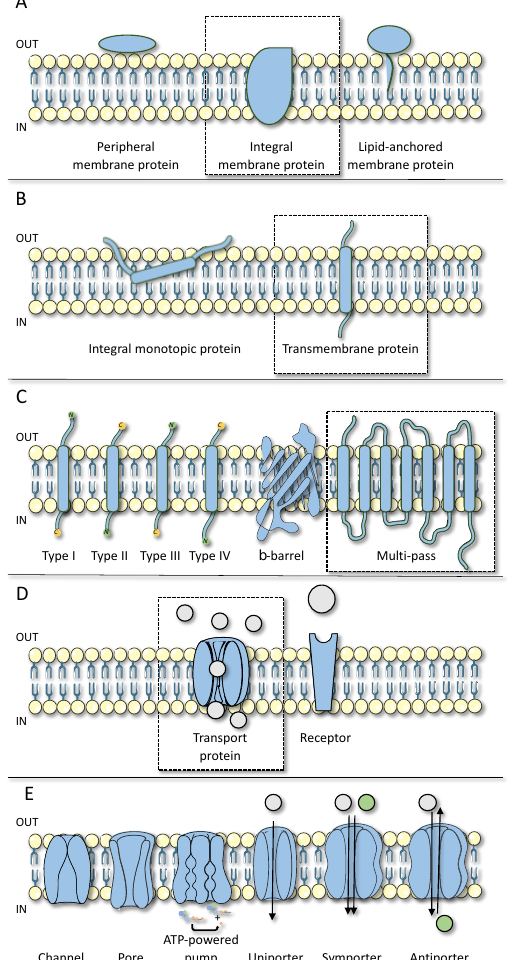
Figure 1. Classification of cell plasma membrane proteins. ( A ) Cell plasma membrane proteins can be divided in 3 general classes, namely integral membrane proteins, peripheral membrane proteins and lipid anchored proteins. ( B ) Integral membrane proteins can be further divided into 2 groups, namely integral monotopic proteins and transmembrane proteins. ( C ) Based on their topology, the family of transmembrane proteins can be classified in type I, type II, type III, type IV, β -barrel and multi-pass transmembrane proteins. ( D ) Multi-pass transmembrane proteins can be divided into different classes based on their function, namely transport proteins and receptors. ( E ) Transport proteins include channels and pores, ATP-powered pumps and 3 types of porters, namely uniporters, symporters and antiporters.